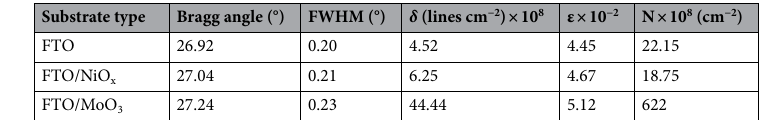
Table 2. Structural parameters of the CISe films deposited on various substrates.